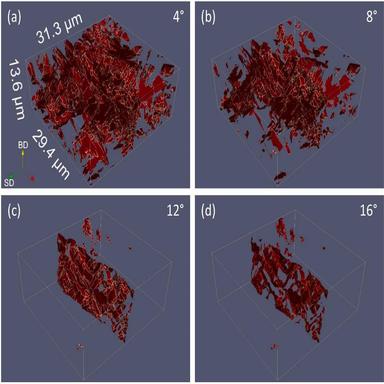
All the boundaries in the linear sample classified as RHAGBs by the algorithm in with different tolerance values (a) 4◦, (b) 8◦, (c) 12◦, and (d) 16◦.